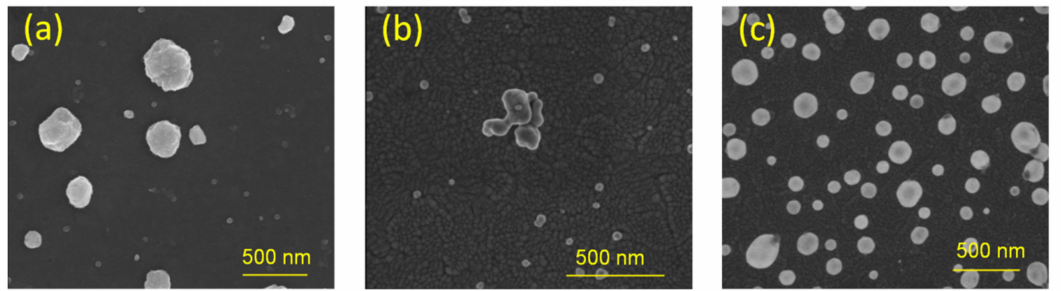
Figure 3. Scanning electron microscopy images of SIF substrates prepared with wet-chemistry methods, using glucose ( a ), formaldehyde ( b ) and cetyltrimethylammonium bromide (CTAB) ( c ). The scale bar is 500